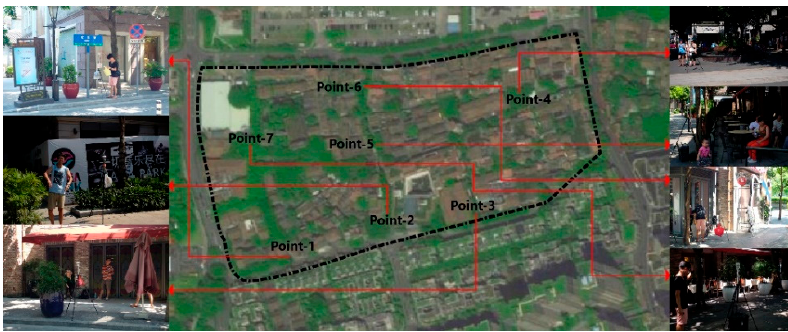
Figure 6. The location of the different selected points.